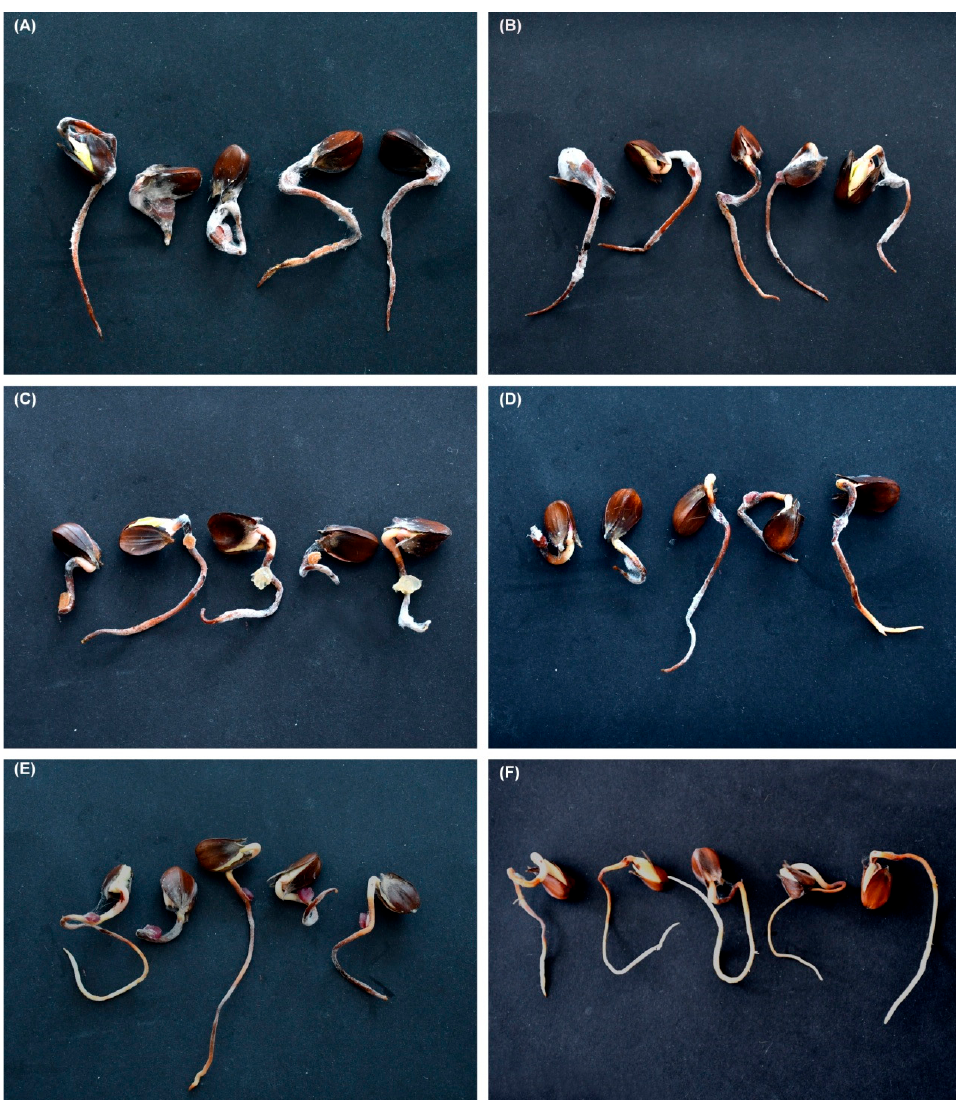
Figure 6. Necrosis on beech germinants inoculated with: ( A ) Fusarium avenaceum (53HS); ( B ) F. avenaceum (17HS); ( C ) F. sambucinum (14HS); ( D ) F. sporotrichioide s (48HS); ( E ) Fusarium sp. B avenaceum (17HS); ( C ) F. sambucinum (14HS); ( D ) F. sporotrichioides (48HS); ( E ) Fusarium sp. B (10HS); (10HS); ( F ) control. ( F )